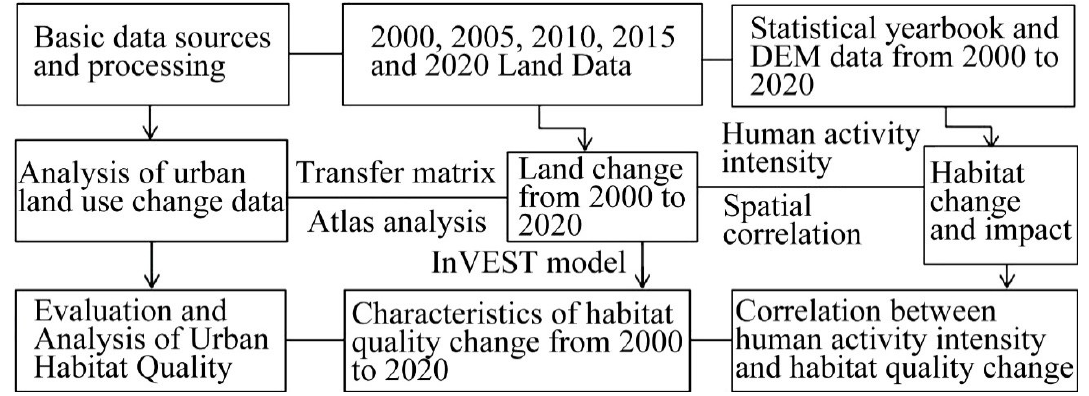
Figure 2. Research